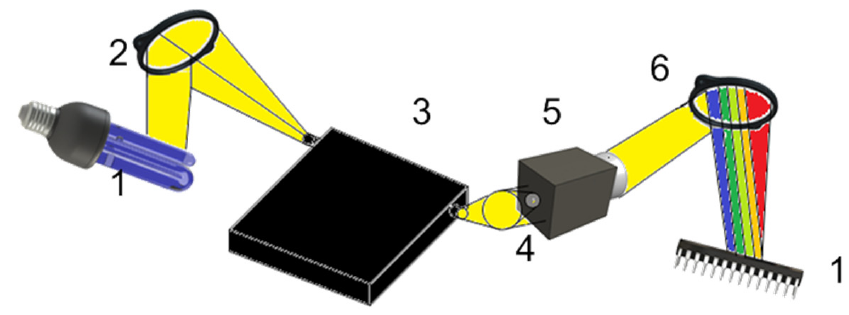
Figure 5. Elements that integrate a high-performance liquid chromatograph.